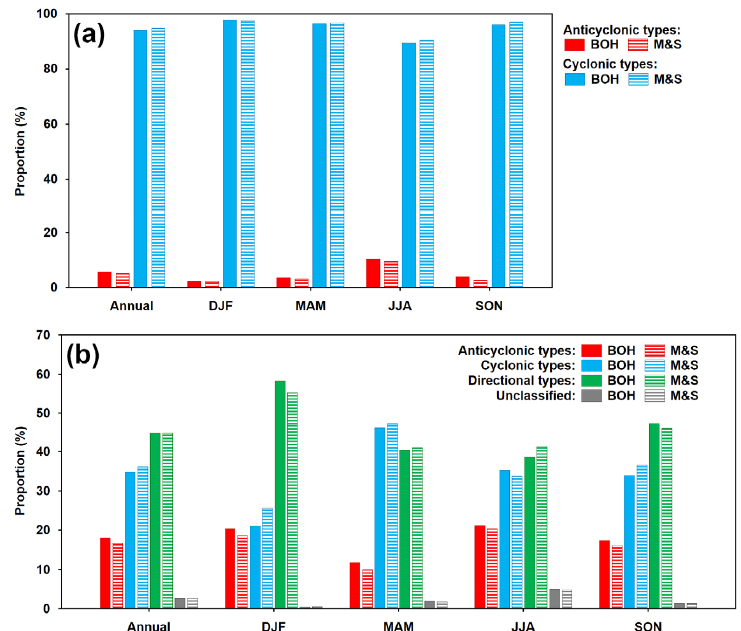
Figure 5. Relative annual and seasonal (DJF: December–February; MAM: March–May; JJA: June– August; and SON: September–November) proportions (%) of the groups of circulation types under the CHMI ( a ) and objective ( b ) classifications in the overall precipitation totals in Bohemia (BOH) and Moravia and Silesia (M&S) during the 1961–2020